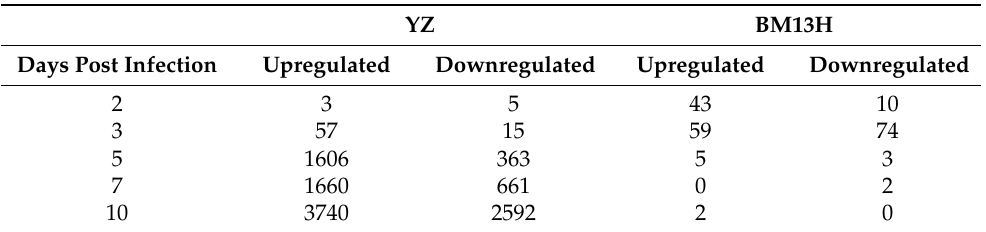
Table 1. Number of differentially expressed genes (DEGs) between infected and uninfected root tissue during BRR infection of BM13H and YZ.